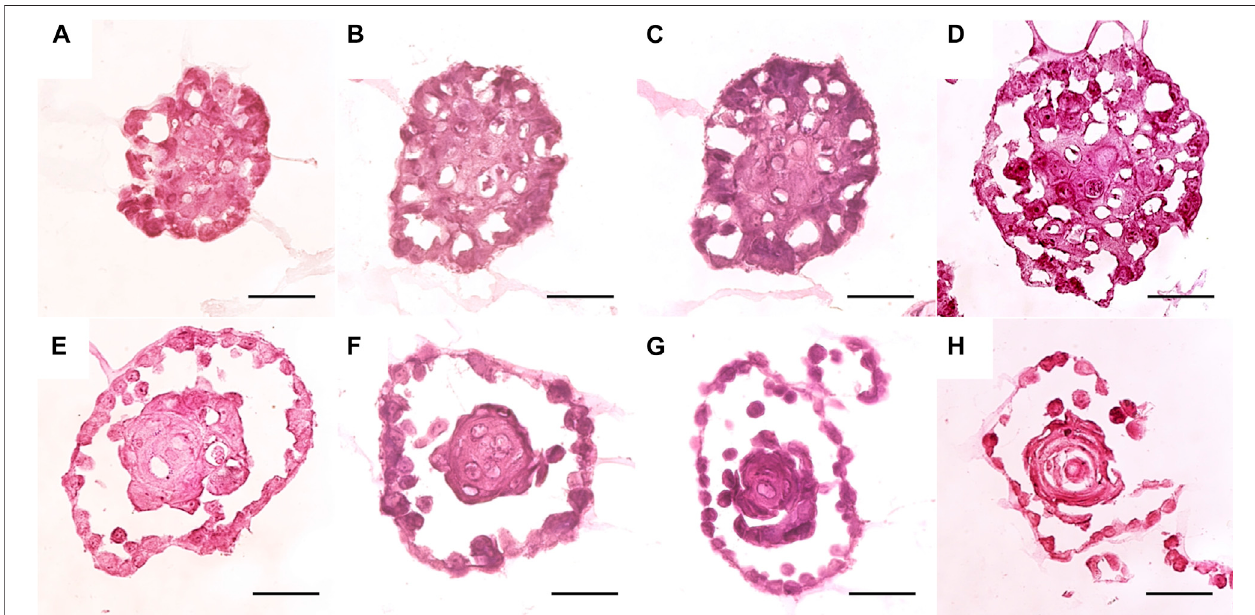
FIGURE 3 | Histology of HAT-7 spheroids grown for 7 days in Matrigel with Hepato-STIM medium. Spheroids were isolated from the matrix using 0.25% trypsin/ EDTA. Frozen sections (5 µm) were stained with haematoxylin and eosin. Scale bars: 50 µm.